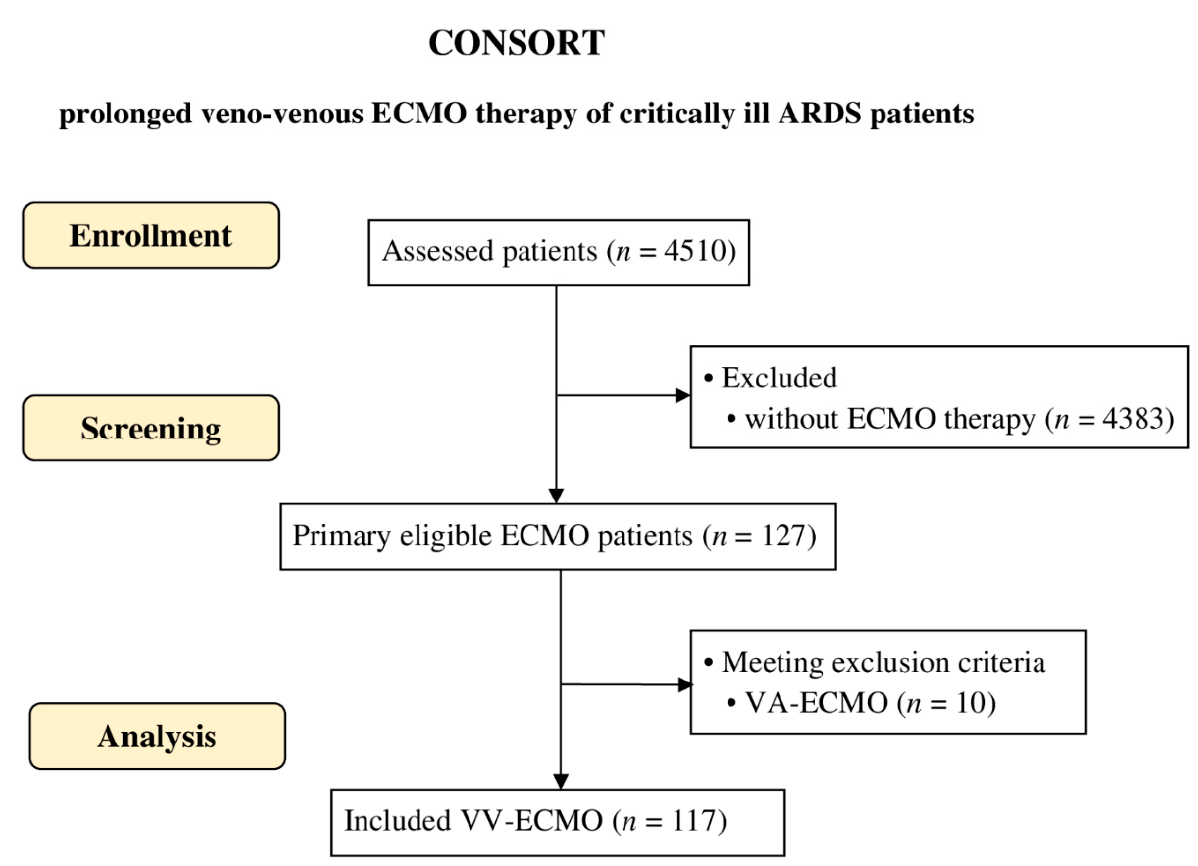
Figure 1. Patient inclusion. Patient inclusion of the study presented as diagram, according to Consolidated Standards of Reporting Trials (CONSORT). Table 1. Clinical